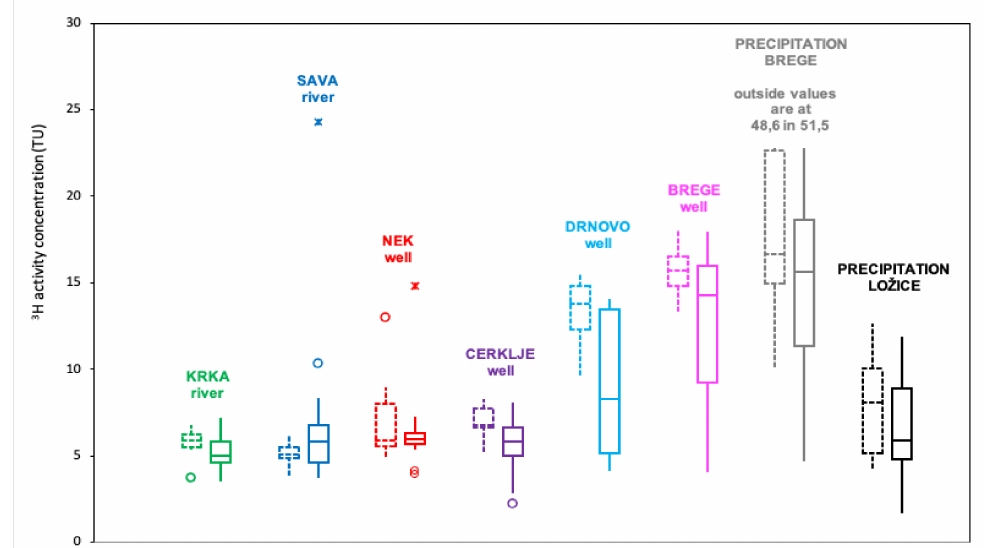
Figure 9. Distribution of concentrations of tritium activity with upper and lower quartile, median, outside, and far-out values in precipitation, surface water, and groundwater sampled before (dashed line) and after (solid line) filling of the accumulation basin for the HPP